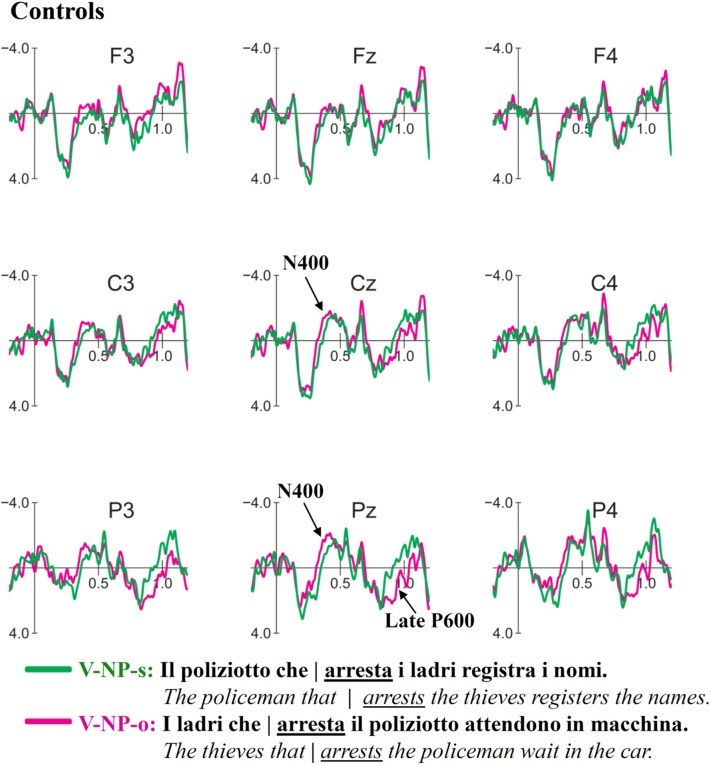
Event-related-potentials (ERPs) elicited by the verb in response to V-NP-object sentences (pink) compared to V-NP-subject sentences (green) in Controls. Time ranges depicted on the x-axis are relative to the onset of the verb of the relative clause (0 ms). Negative values are plotted up. Controls show an N400 effect followed by a late, posterior P600 effect.